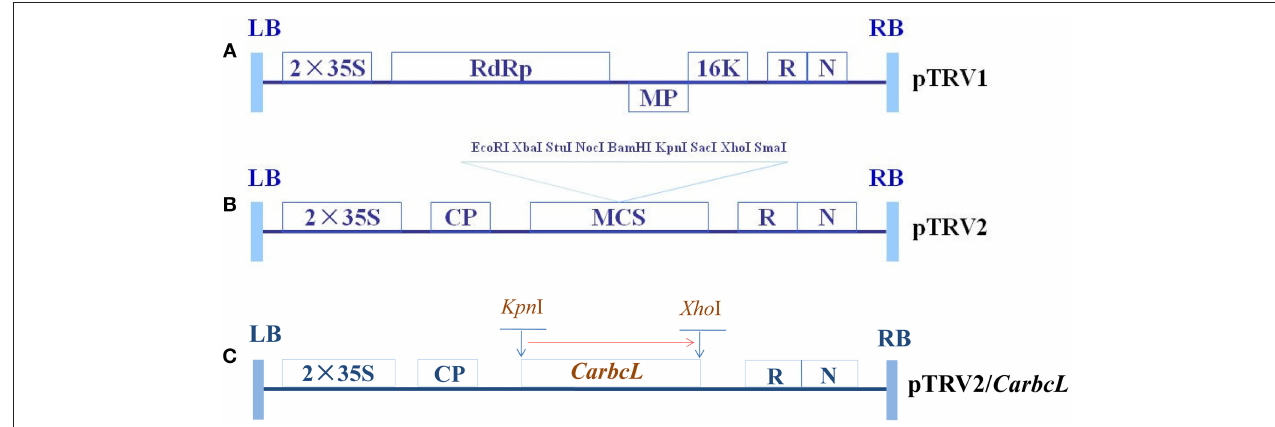
FIGURE 1 | Schematic representation of TRV and recombinant TRV vectors carrying the target genes. (A) The structure of pTRV1; (B) The structure of pTRV2; (C) The structure of TRV- CarbcL . LB, left border of the T-DNA; RB, right border of the T-DNA; 2 × 35 S: two copies of the cauliflower mosaic virus 35S promoter; CP, coat protein; RdRp, RNA-dependent RNA polymerase; MP, movement protein; 16K, 16 KDa protein; R, ribozyme; N, NOS terminator; and MCS, multiple cloning site.